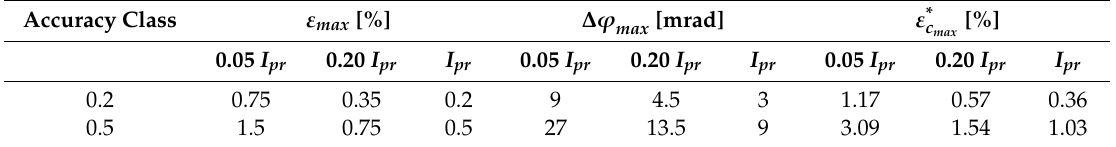
Table 9. ε and ∆ ϕ limits for the 0.2 and 0.5 accuracy classes transformers defined in [2]. The table has been extended with ε ∗ c obtained from the limits ε max and ∆ ϕ max